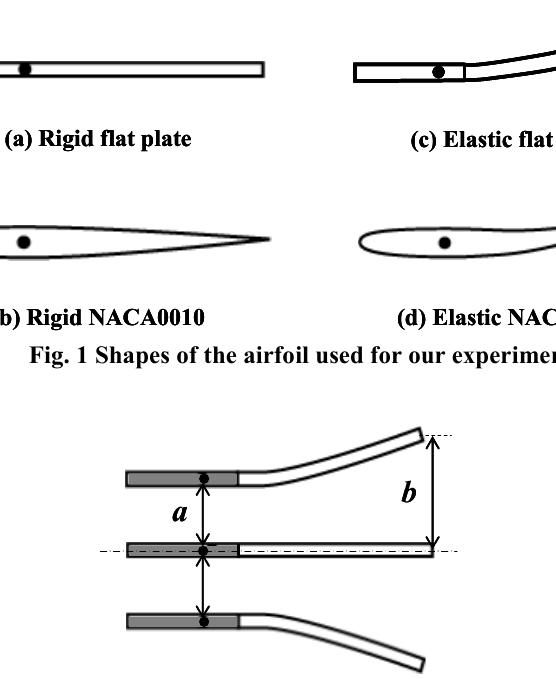
Fig. 2 Elastic deformation for the elastic airfoil